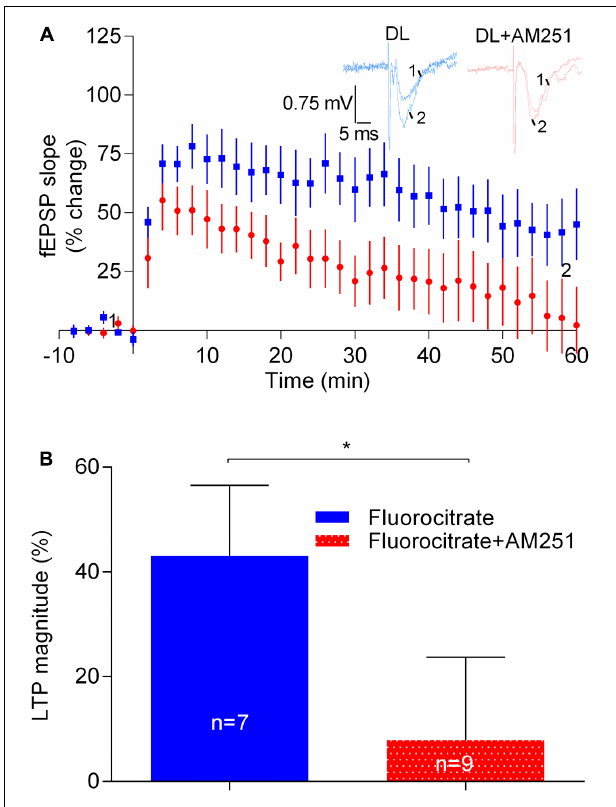
FIGURE 7 | The influence of physiologically released eCB upon strong- θ -burst-induced LTP is lost upon blockade of GABAergic transmission. (A) Data obtained in slices treated with the GABA A receptor antagonist, PTX (50 µ M) in the absence (control) or in the presence of 1 µ M of AM251. (B) Quantification of LTP magnitude under the indicated conditions. No significant differences between both conditions were found ( F ( 5 , 4 ) = 1.9, p > 0.05, Student’s t -test). For further details see legend to Figure 1